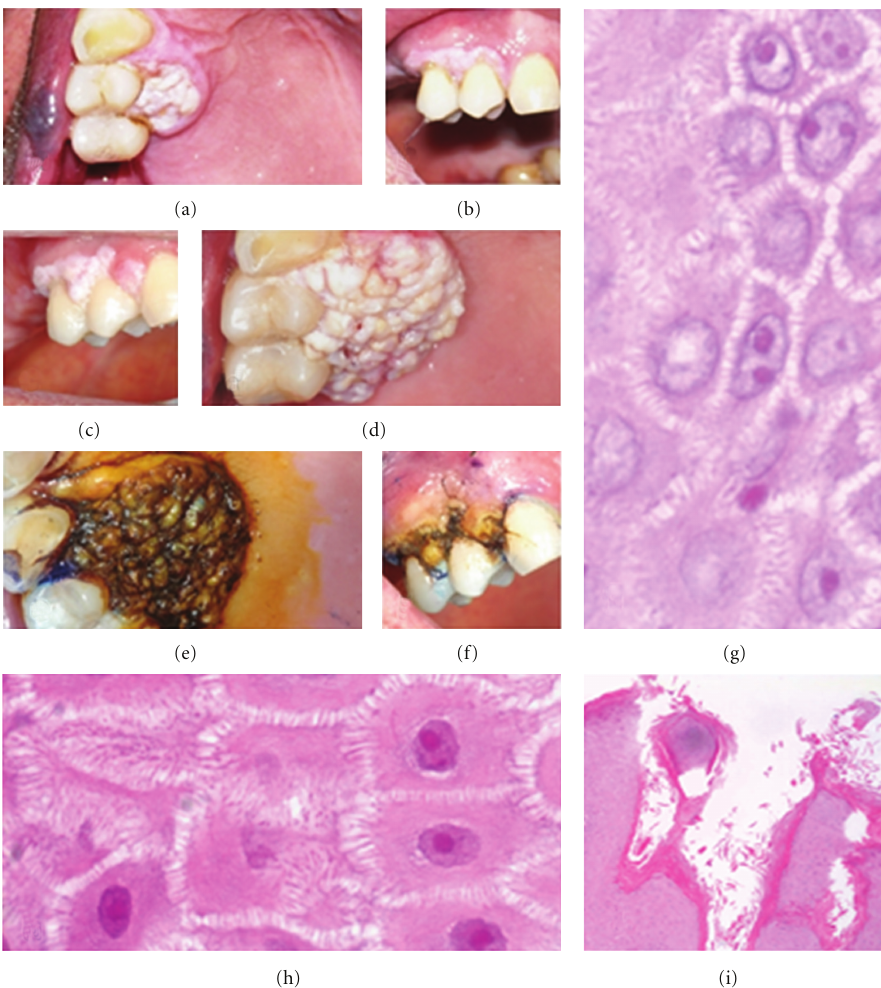
Figure 1: Clinical findings and histopathological details. Clinical aspects at the first observation: a verrucous, exophytic mass, about 1cm in diameter, localized in the hard palate (a) at the upper right premolars and extending to the vestibular side of the gingival (b). Clinical findings 15 days later: in two weeks the lesion grew larger and triplicated its size (c, d). Staining by toluidine blue and Lugol was performed to guide incisional biopsies (e, f). Histological details of an area with mild basal cytological atypia: vesicular nuclei with prominent eosinophilic nucleoli ((g, h); Haematoxylin and Eosin, × 40). Superficial “church pinnacles” dyskeratosis ((i); Haematoxylin and Eosin, ×